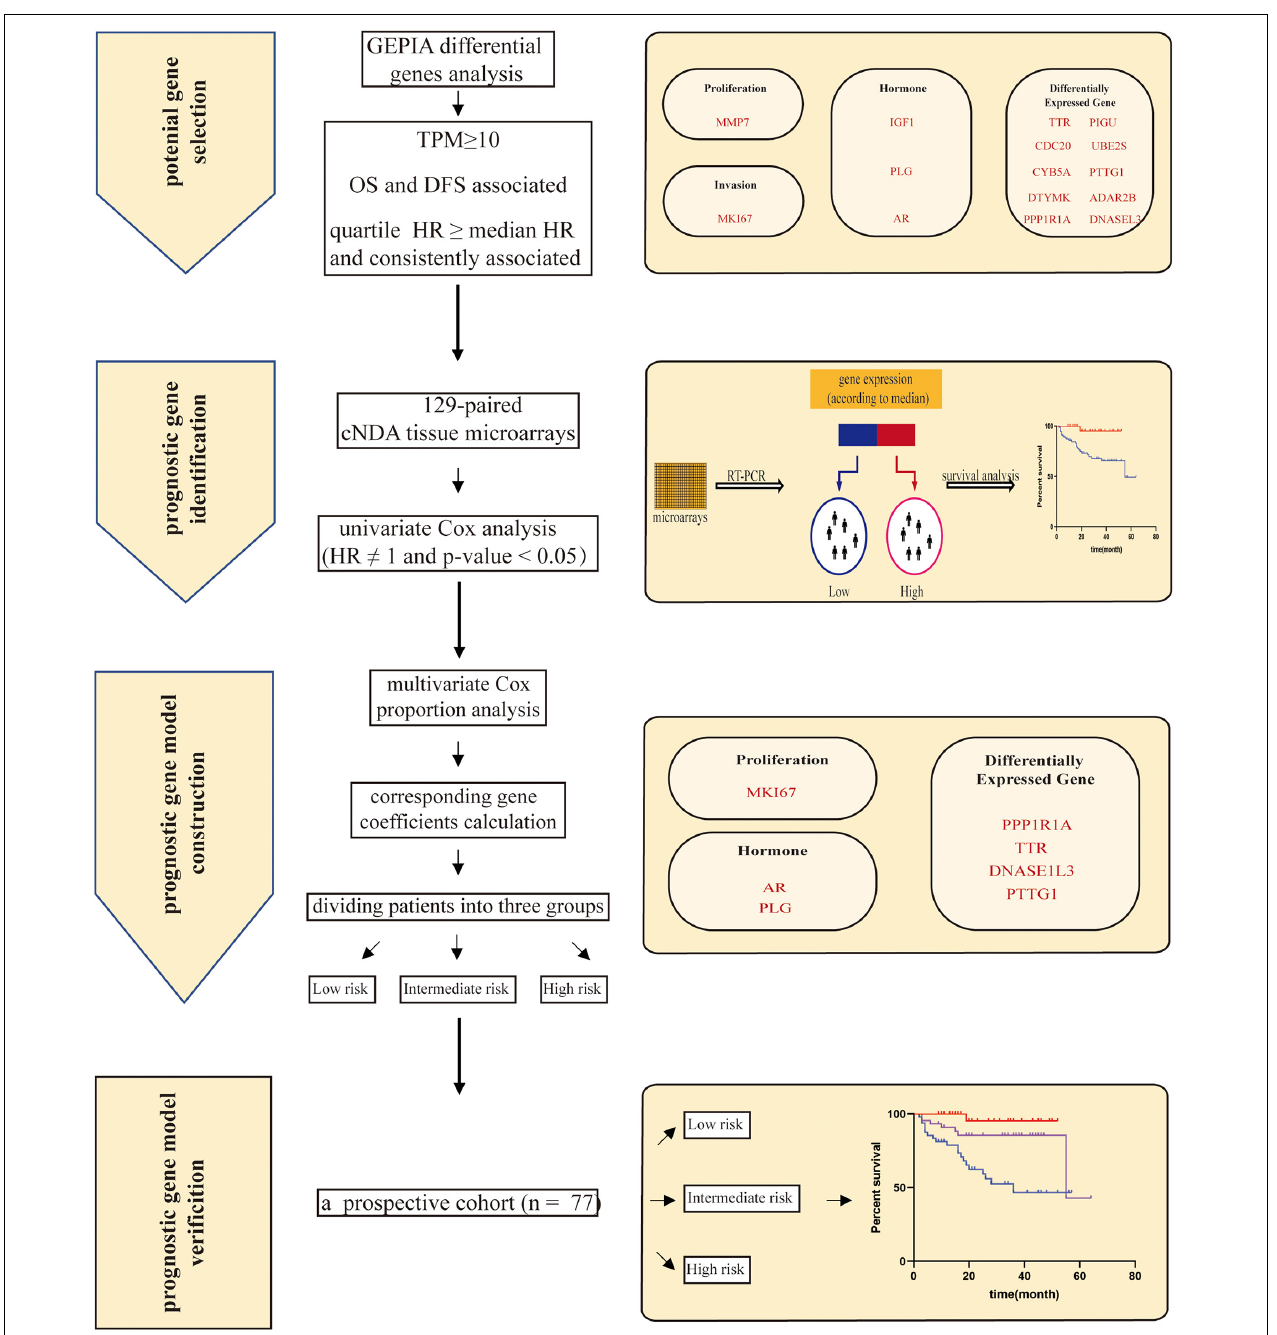
FIGURE 4 | The workflow of our study. First, a list of 15 candidate genes was selected from GEPIA (Gene Expression Profiling Interactive Analysis). Second, a seven-gene signature was identified based on independent survival analysis by Kaplan–Meier curves and a log-rank test. Genes are grouped on the basis of function, covering proliferation: MKI67 (marker of proliferation Ki-67); invasion: MMP7 (matrix metallopeptidase 7); hormone: PLG (plasminogen), IGF1 (insulin like growth factor 1), and AR (androgen receptor); and differentially expressed genes: DNASE1L3 (deoxyribonuclease 1 like 3), PTTG1 (PTTG1 regulator of sister chromatid separation, securin), CDC20 (cell division cycle 20), UBE2S (ubiquitin conjugating enzyme E2 S), PIGU (phosphatidylinositol glycan anchor biosynthesis class U), DTYMK (deoxythymidylate kinase), CYB5A (cytochrome b5 type A), PPP1R1A (protein phosphatase 1 regulatory inhibitor subunit 1A), ADAR2B (adenosine deaminase RNA specific 2b), and TTR (transthyretin). Then, the multivariate Cox proportion model was given to perform the coefficient of the individual gene and calculate a risk score. Risk score = (0.368 × ExprMKI67 + 1.082) + ( − 0.719 × ExprPTTG1 + 0.424) + (0.286 × ExprDNASE1L3 - 1.276) + (0.204 × ExprPLG + 0.172) + (0.173 × ExprAR - 0.702) + (0.153 × ExprPPP1R1A - 0.731) + (0.286 × ExprTTR - 0.779). The risk score ranged from 1 to 14. Patients were classified into three groups (low, intermediate, and high) by risk score. Finally, the prognostic prediction model of risk scores was verified using an independent prospective cohort.